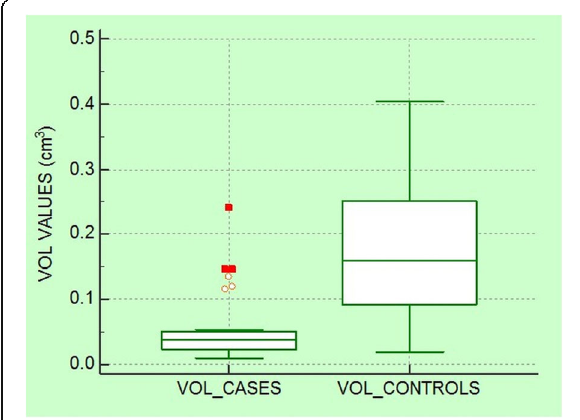
Fig 4 Box plot showing the olfactory bulb and tract volume in cases and